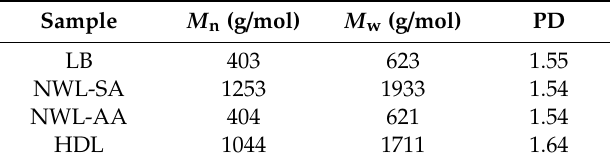
Table 6. Macromolecular traits of lignin samples determined by size exclusion chromatography.